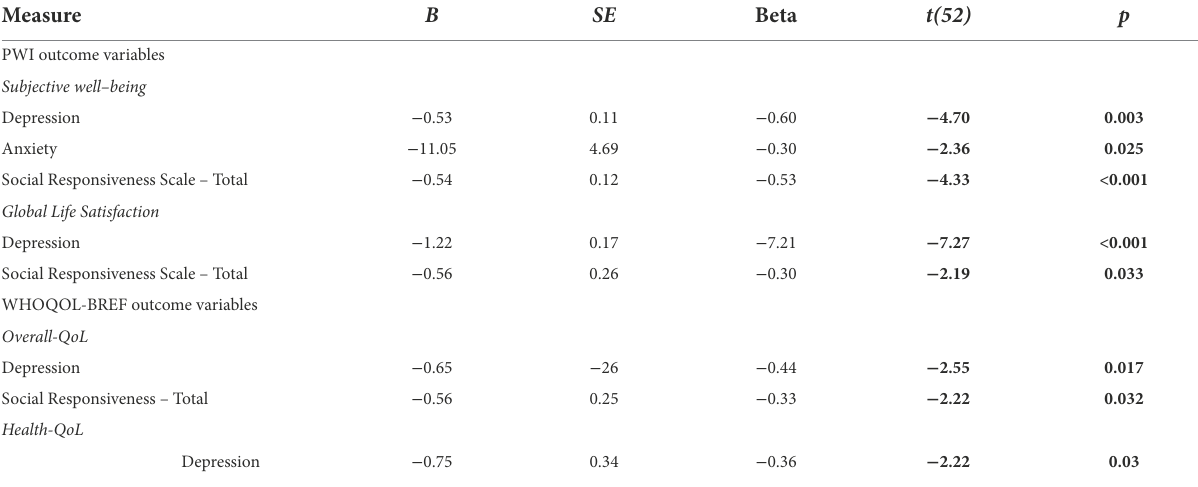
TABLE 6 T1 predictors of quality of